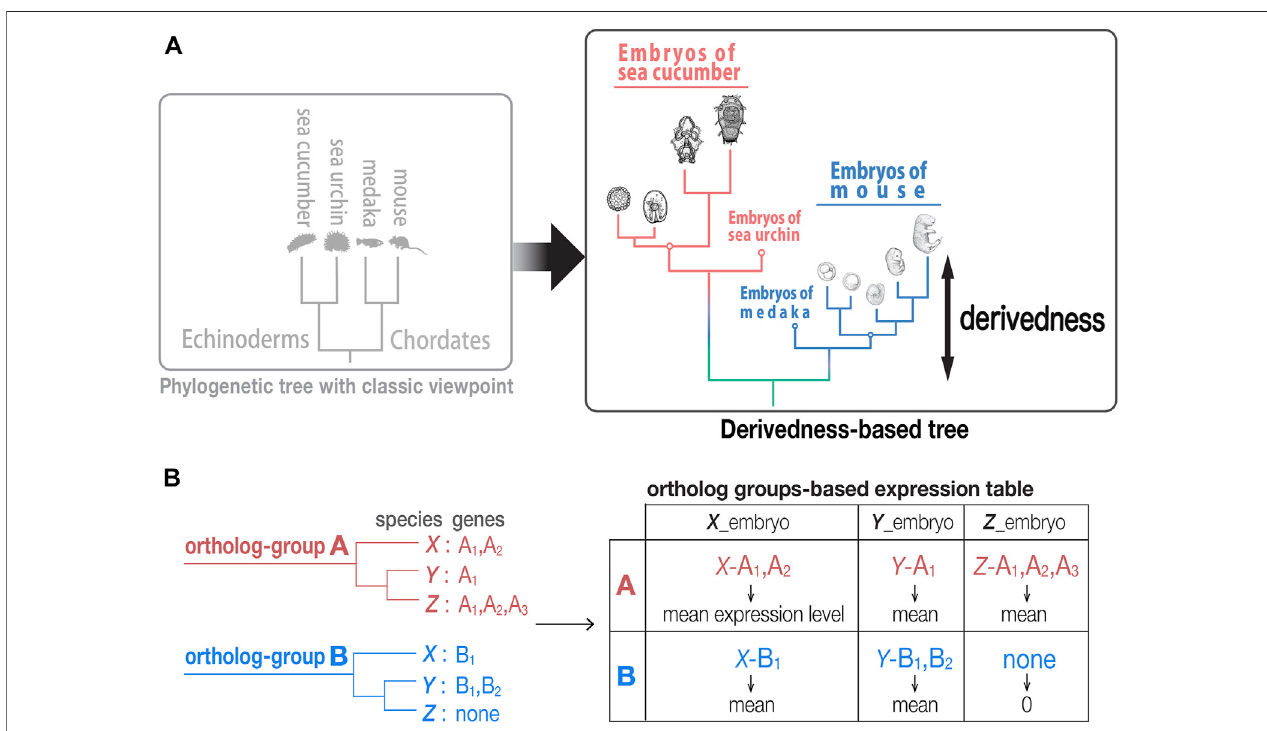
FIGURE 1 | Tree based on phenotypic derivedness of embryos. (A) Schematic illustration of a phylogenetic tree drawn by classic viewpoint (left) and that by transcriptomic derivedness(right). Phenotypic derivednessaimstointroducequantitativeevaluation ofhowderivedeach sampleorembryobecame fromtheircommon ancestor. (B) In contrast to evaluating conservation with commonly shared genes, such as 1:1 orthologs, our method takes advantage of ortholog group-based expression table, which considers the expression of paralogs and potential lost genes.